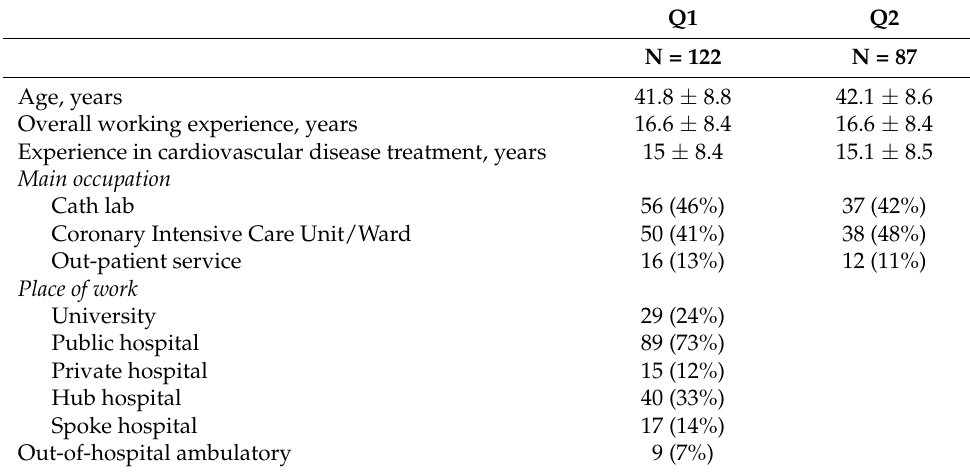
Table 1. Characteristics of the study